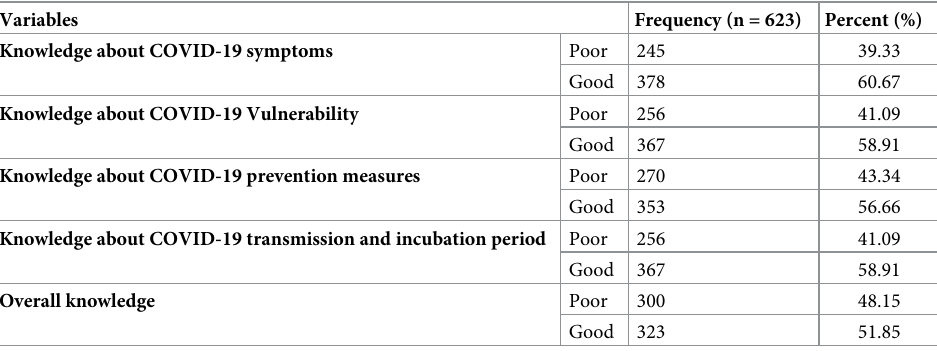
Table 2. Knowledge of the study participants about COVID-19 in Gondar city, northwest Ethiopia, 2020.